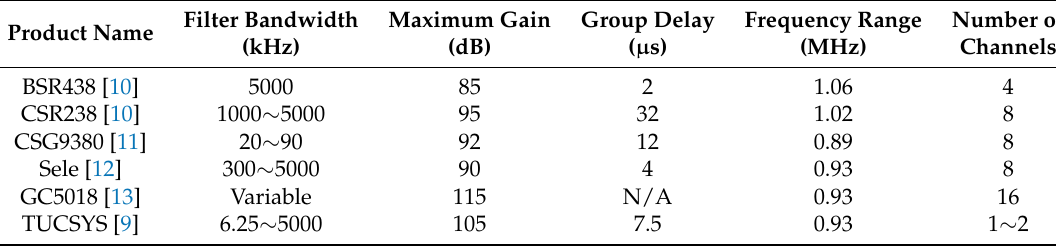
Table 1. Properties and specifications of industrial